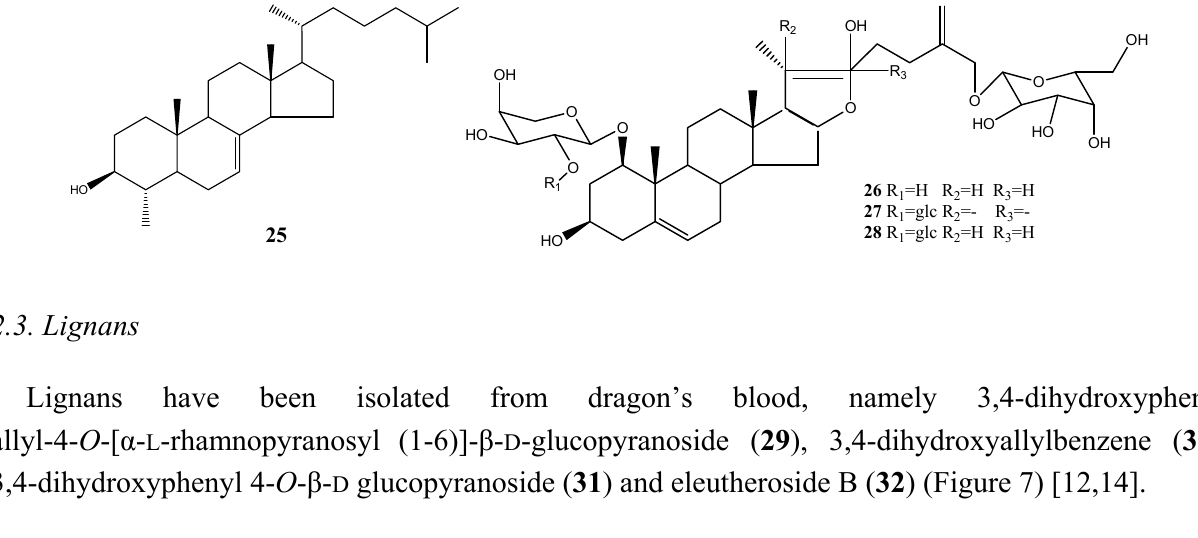
Figure 7. Structures of lignans.